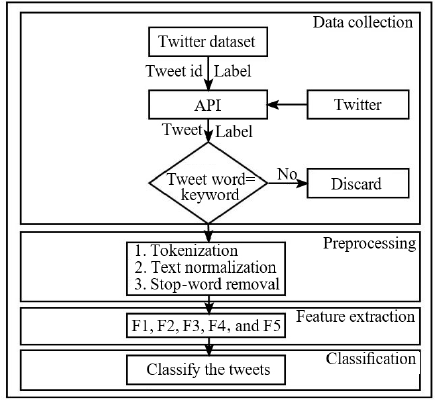
Fig. 1 Overview of the proposed event detection